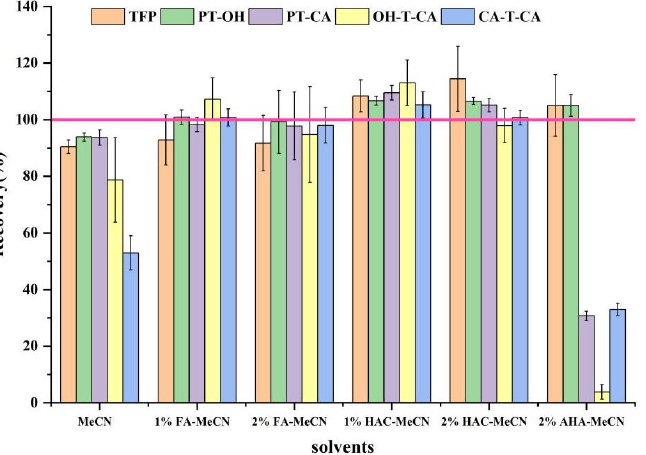
Figure 1. The recoveries of TFP and its metabolites in different extraction solvents (the red horizen line represents the recovery of 100%, and the closer to it, the higher the